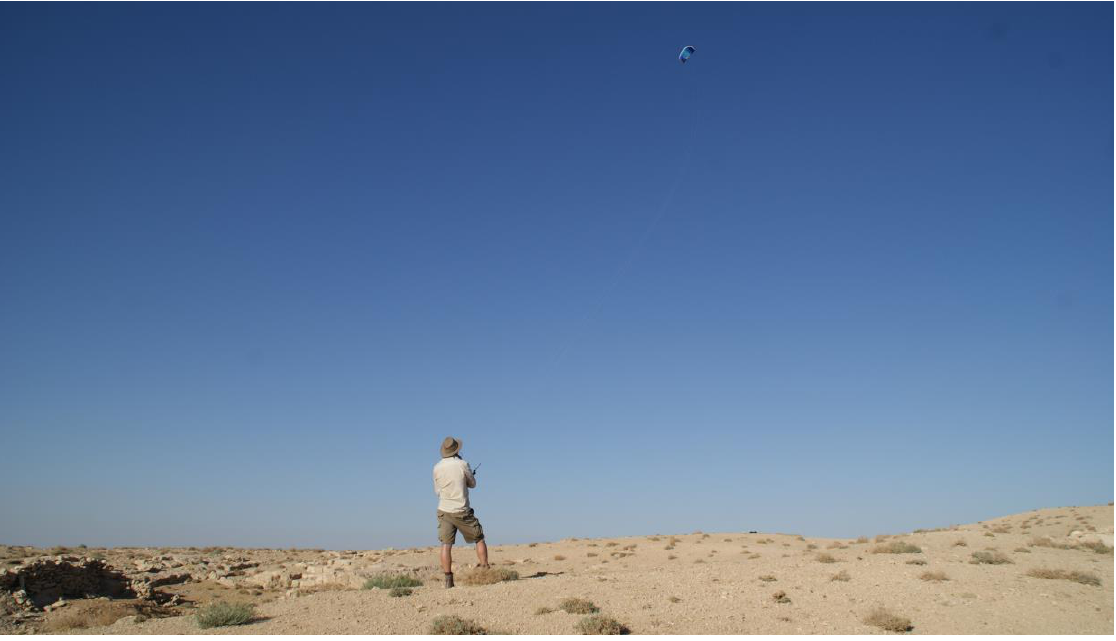
Figure 5. Operation of the kite. Photograph by M.H.